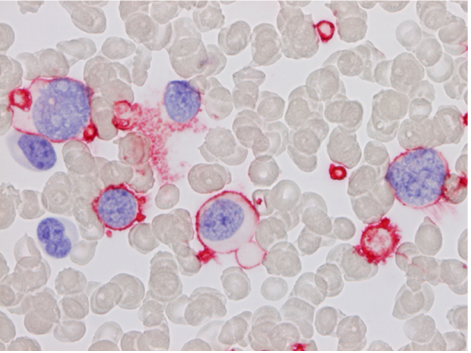
Figure 1. Acute megakaryoblastic leukaemia stained with CD61 using the APAAP method. The blast cells show surface staining. Platelets are also positive (blood smear; haematoxylin counterstain. ×1000).